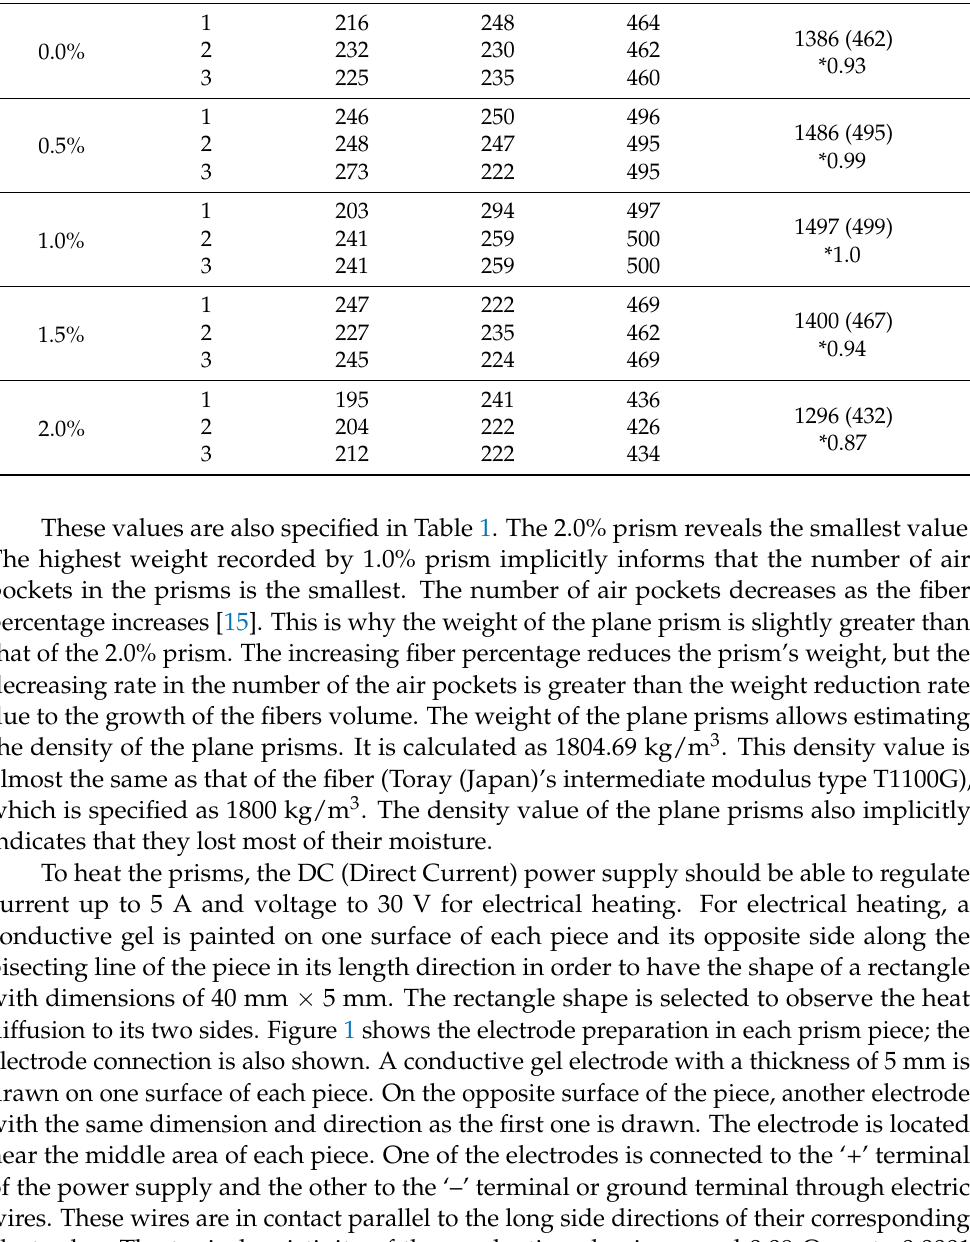
Table 1. Weights of four different percentage prisms: Each percentage has 3 prism samples. Sam. No. Left (g) Right (g) Sum (g) 1 216 248 0.0%